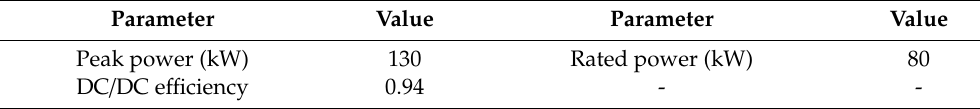
Table 5. Fuel cell parameters.